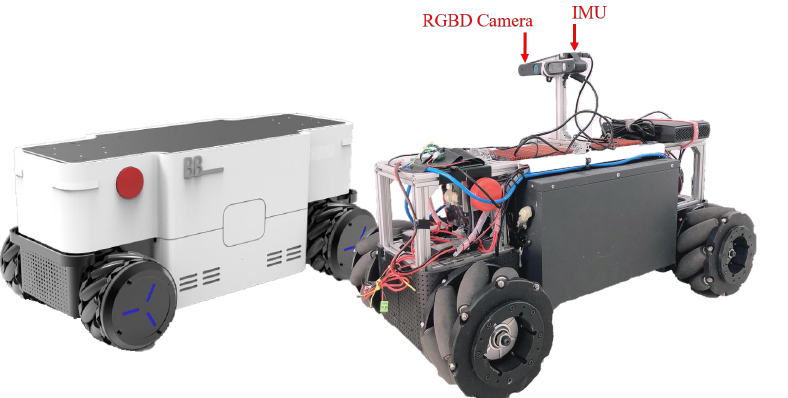
Figure 17. A four-wheeled mobile robot platform called BootBot. It is equipped with an Xtion RGBD camera and an inertial measurement unit (IMU). These sensors are placed 20 cm above the middle of the